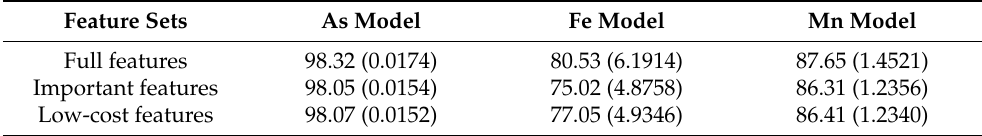
Table 6. Coverage probability of 90% prediction intervals from different inputs: PICP (MPI).